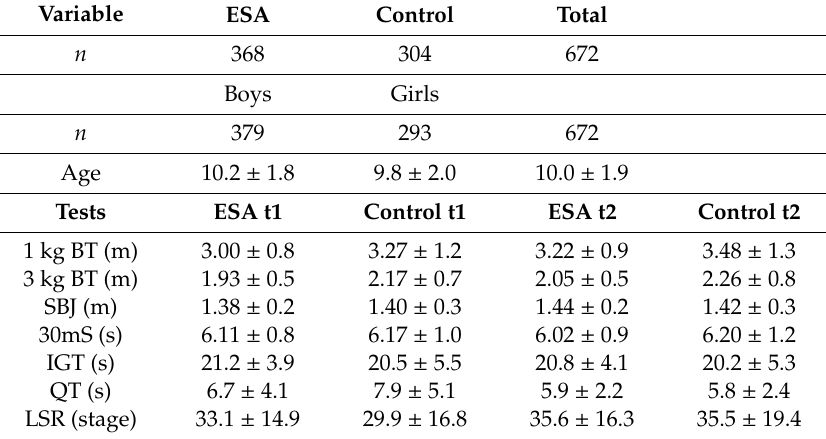
Table 1. Descriptive characteristics of the